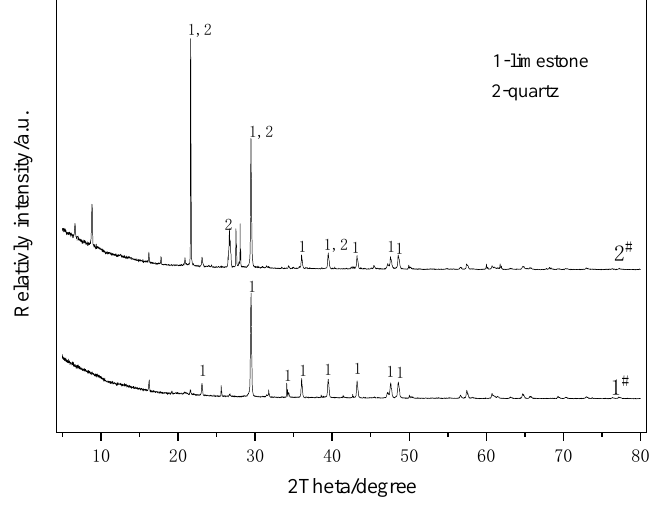
Figure 10. XRD spectrum of 1 # and 2 # admixtures.